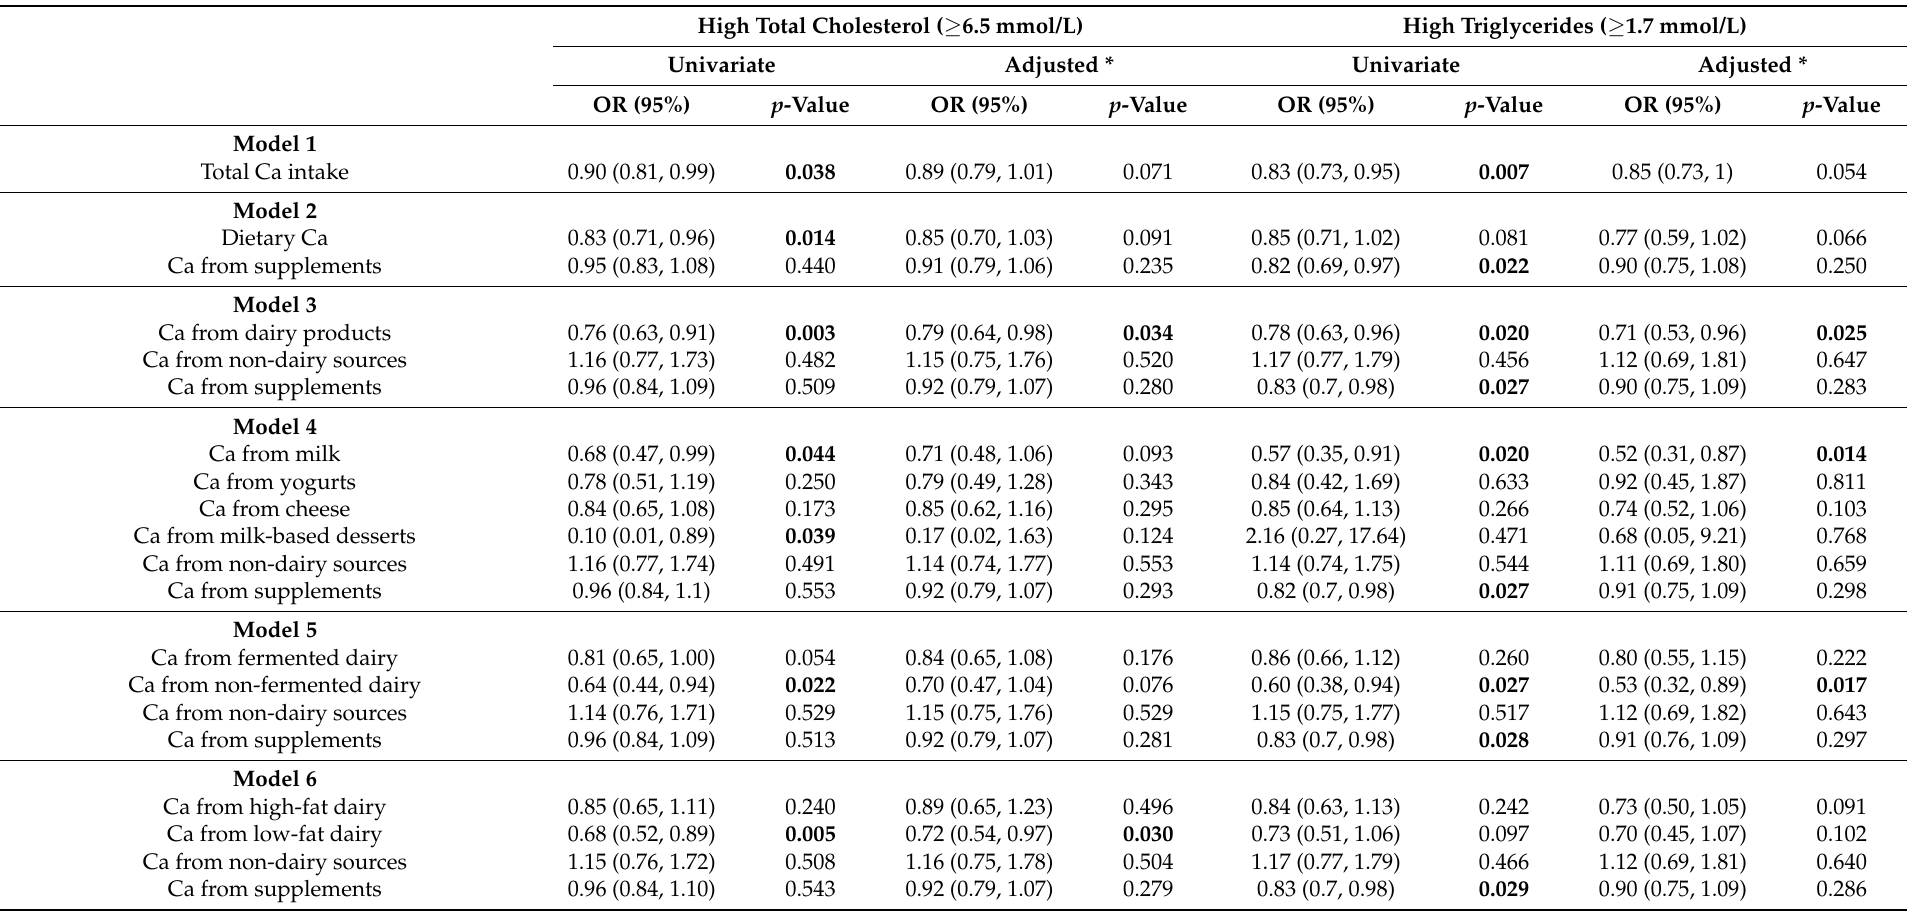
Table 4. Univariate and adjusted ORs and 95 CIs for having high total cholesterol and high triglyceride levels per 300 mg increase in total calcium intake and calcium from different